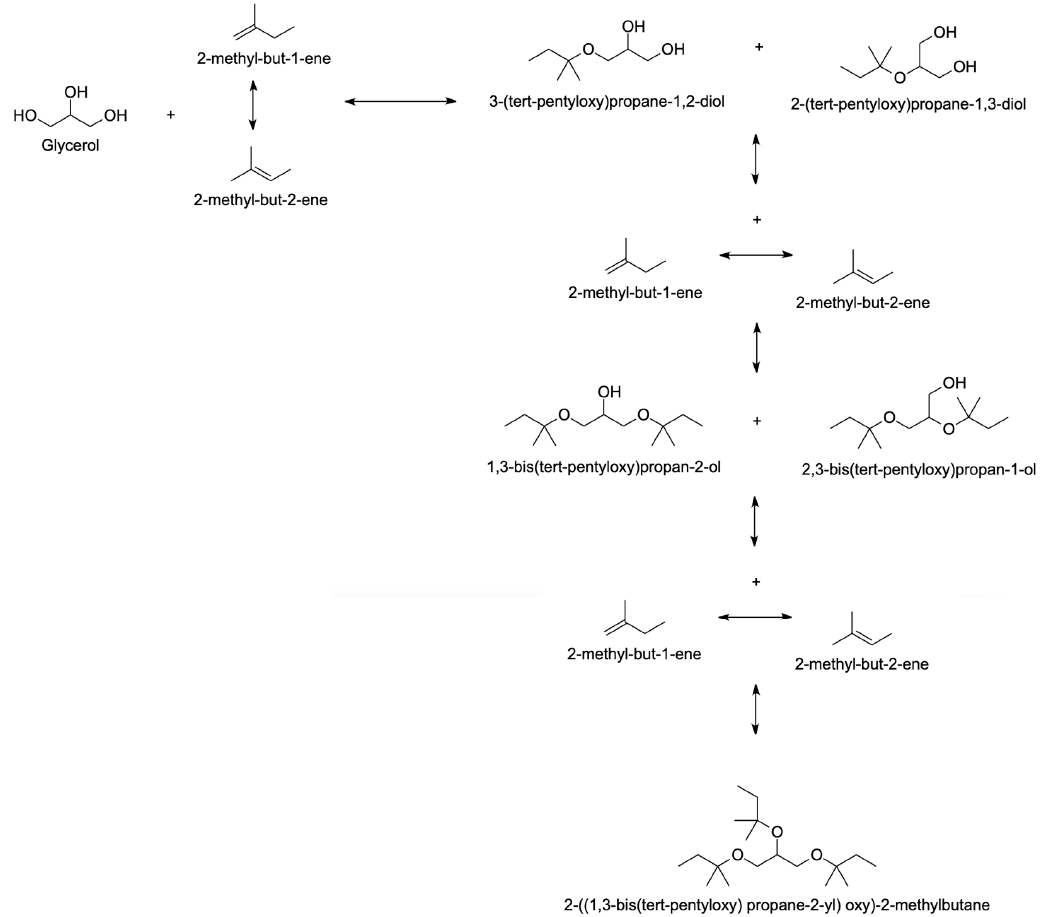
Figure 16. Reaction mechanism of glycerol etherification with isoamylenes [111].